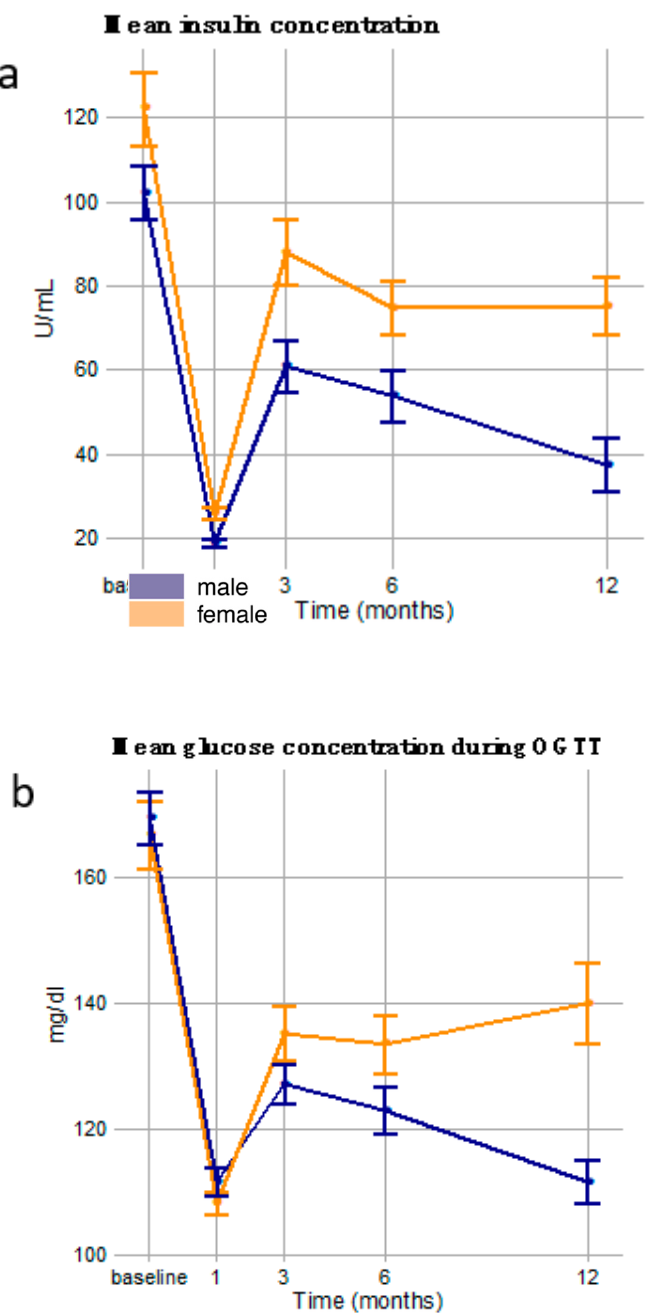
Figure 3. Two most sex-divergent long-term responses (i.e., with the largest difference in 12-month scaled responses between men and women), mean insulin ( a ) and glucose concentrations ( b ) during OGTT, from baseline to final follow-up exam. Points are model-adjusted means (see Methods). Dashed lines represent quadratic fits whose divergence is modeled by the generalized linear mixed models to test for significant time-by-sex interactions. Error bars are for standard errors.